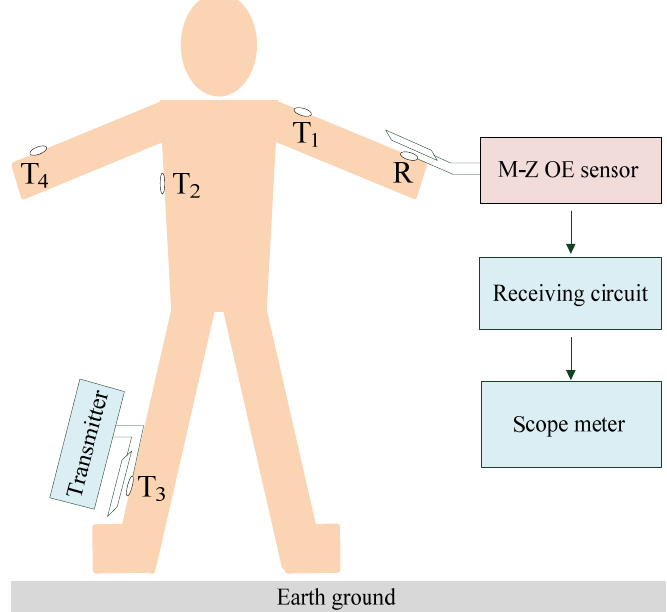
Figure 10. The experiment referring to the influence of signal transmission path in BSN based on human body medium, while the signal transmission paths include the arm path